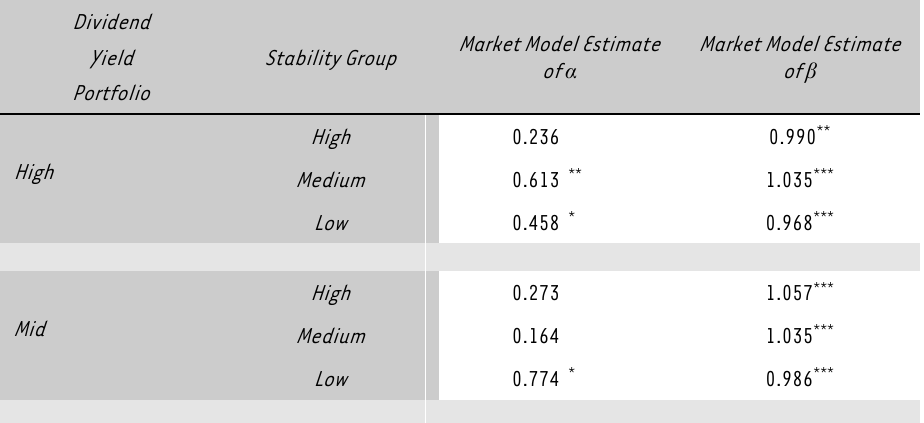
Regression results for the dividend yield-dividend stability